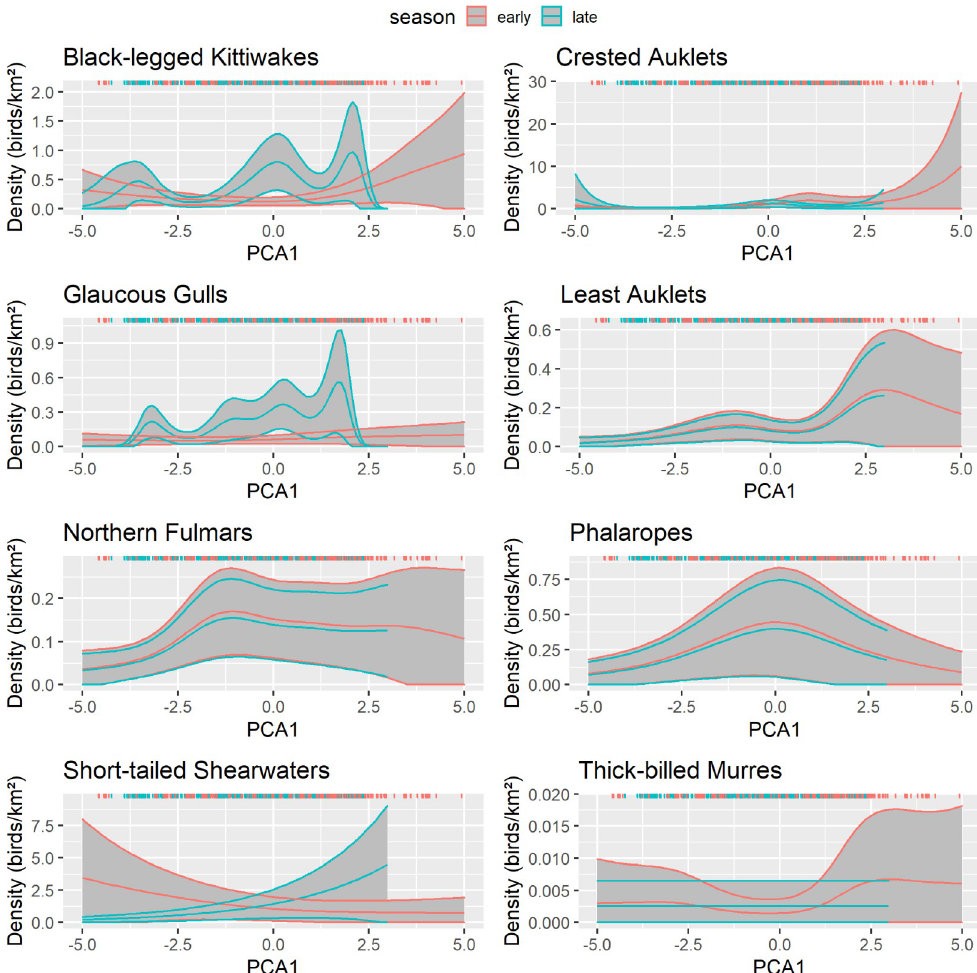
Fig 10. Effect of hydrography on seabird density, northeastern Chukchi Sea, 2008–2018. Response curves are from the best-fitting generalized additive model. Solid lines represent the smooth function and 95% confidence limits for early summer (pink) and late summer (aqua). Gray shading indicates the 95% confidence intervals. Colored ticks indicate the distribution of